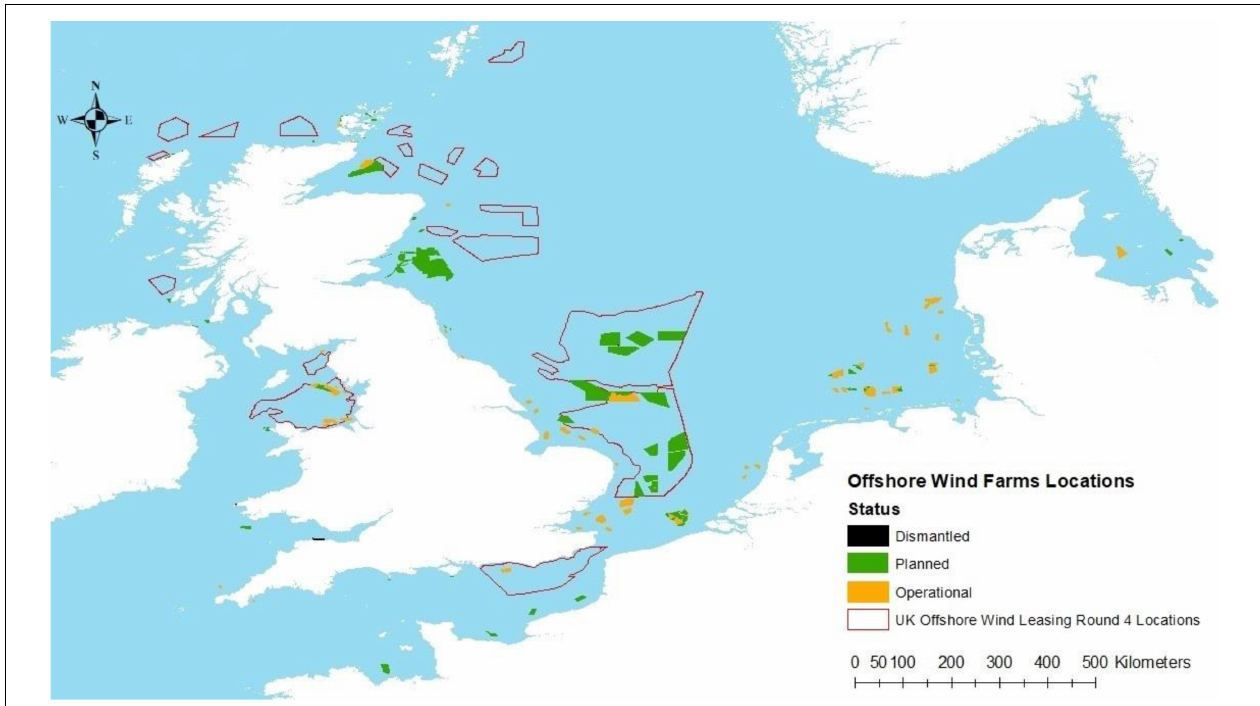
FIGURE 1 | Offshore wind farms locations from past, currently operational and those planned, as well as the range of areas, available for use in leasing round 4.